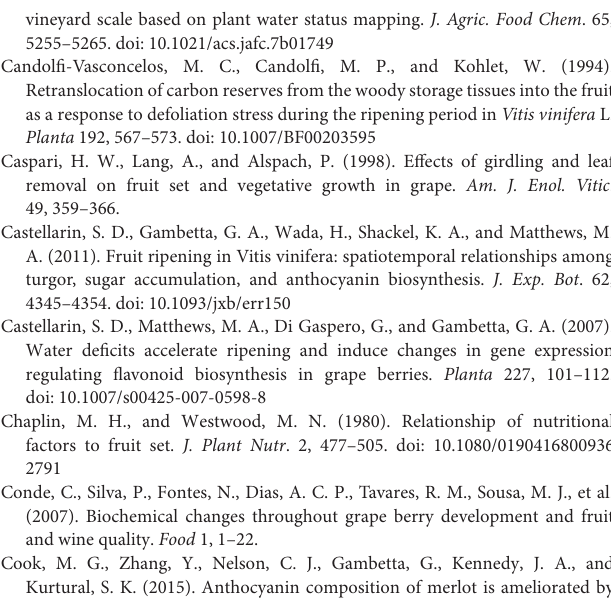
Supplementary Figure 2 | Relationship between yield to pruning weight (Ravaz index) and leaf area to fruit ratio (LA:FR) (A) in 2017, 2018, and 2019; and between LA:FR and berry total soluble soils in 2017 and